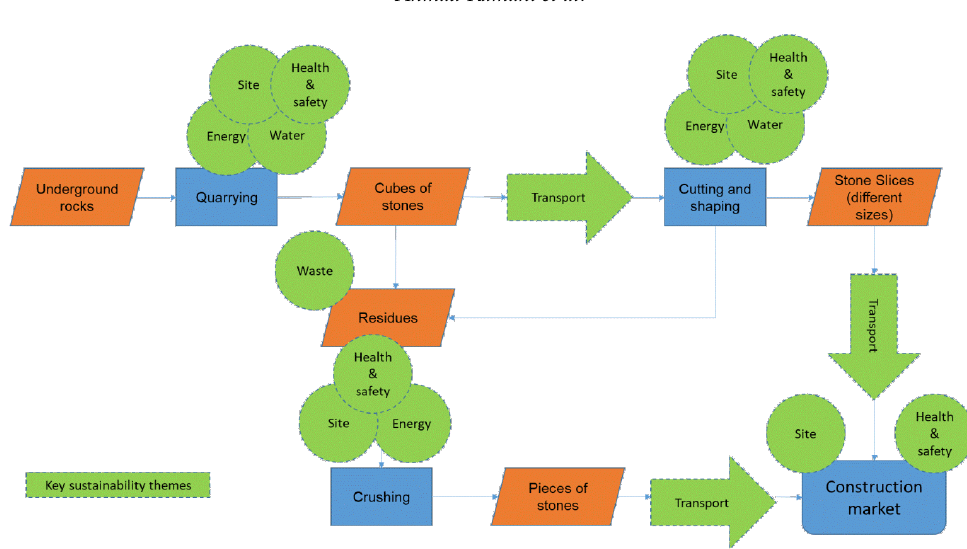
Fig. 1. A brief life cycle of marble and stone industry in Palestine. (Source: authors’ interpretation from the fieldwork) maining are distributed in the middle and the northern areas of the West